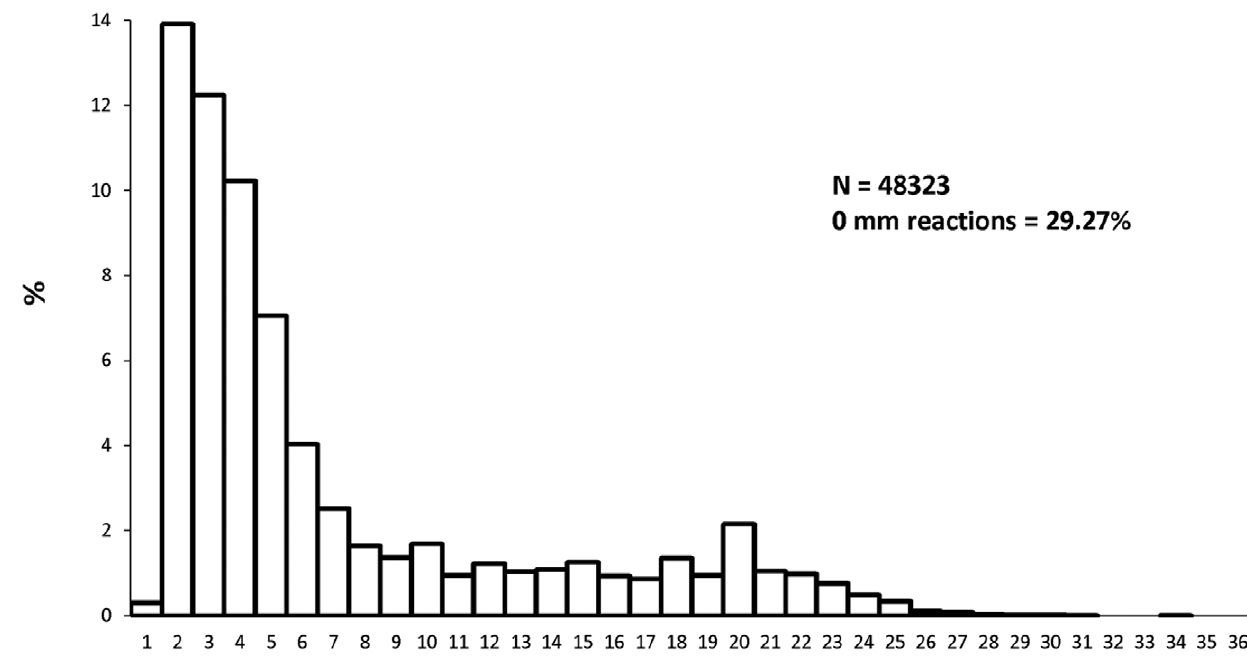
Figure 1. Frequency distribution of tuberculin reaction sizes. Survey I ; Stratum : Both ; BCG : Both; Age : 1–9 years. doi:10.1371/journal.pone.0051854.g001 PLOS ONE |